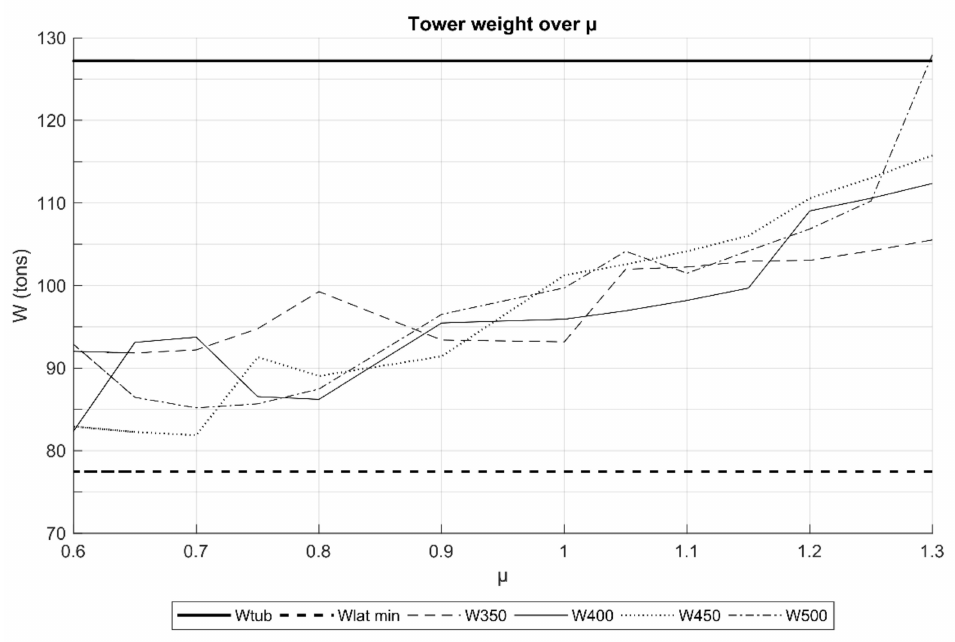
Figure 11. Total weight of tower cases in correlation with µ and B top for the 76 m